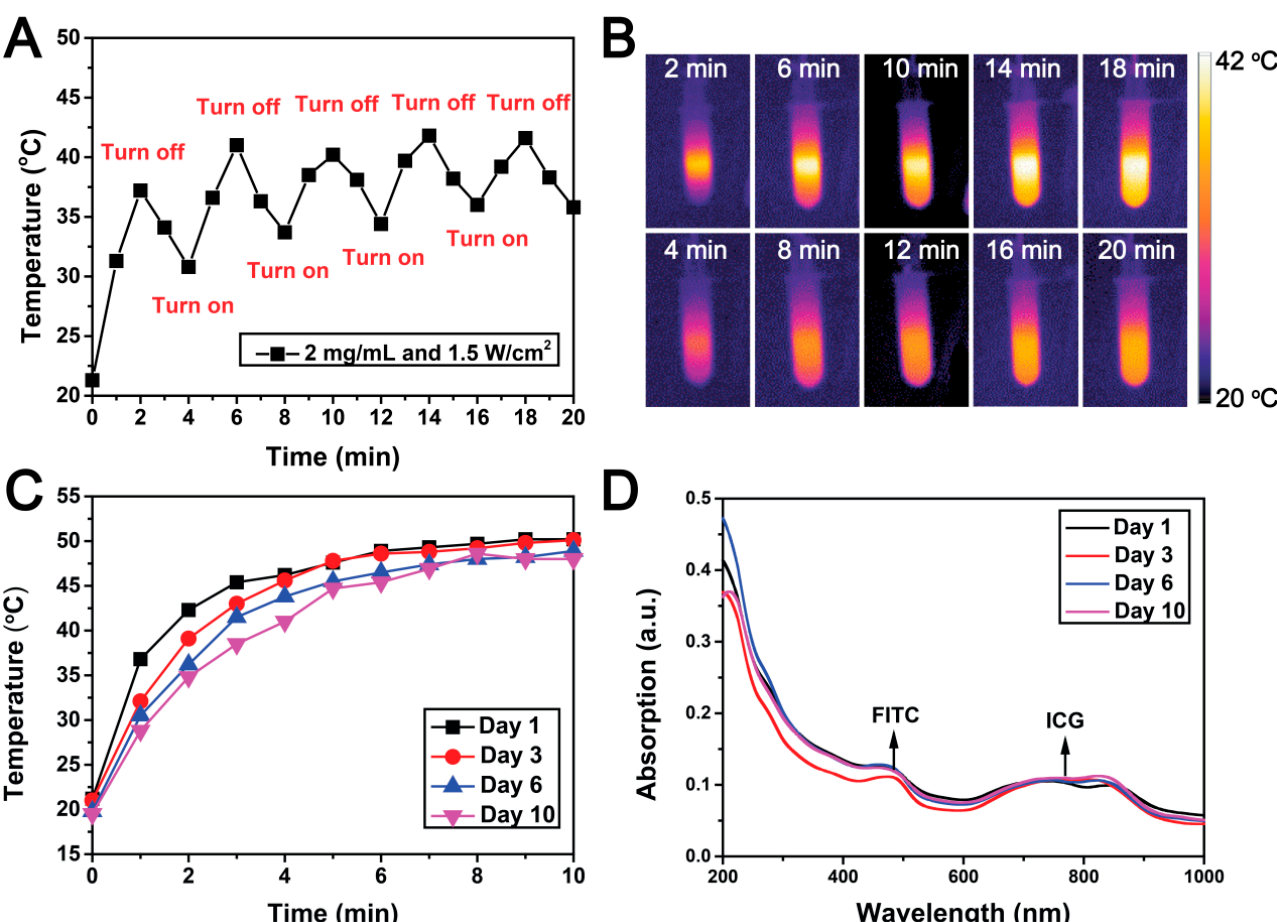
Figure 3. Temperature curve ( A ) and image ( B ) of 1 mL HNTs-FITC-ICG suspension at concentration of 2 mg/mL and under 1.5 W/cm 2 of 808 nm laser, temperature curve ( C ) and UV-vis spectrum ( D ) of HNTs-FITC-ICG suspension tested in day 1, day 3, day 6 and day 10.